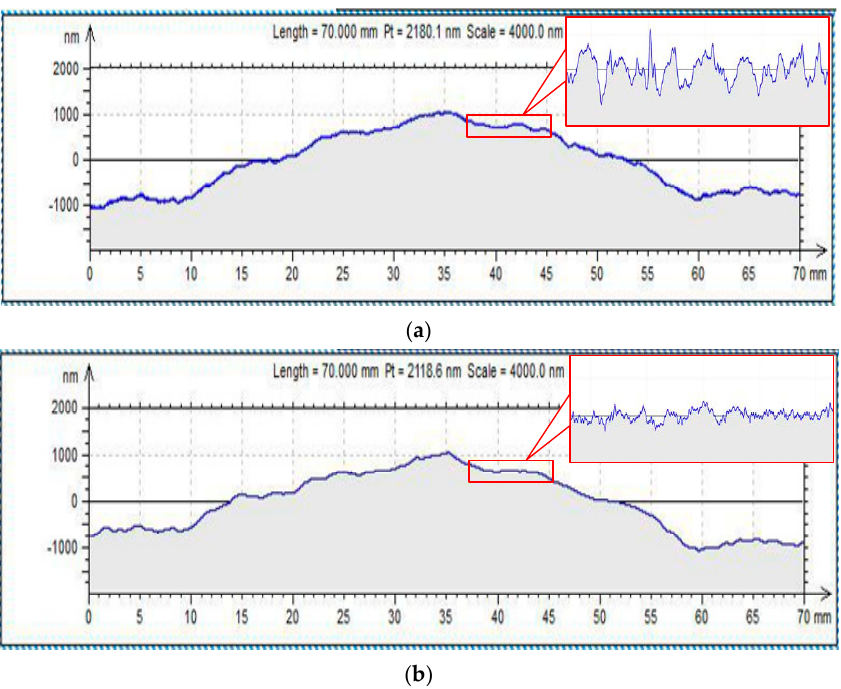
Figure 10. The surface profile of the sample; ( a ) Original and ( b ) polished.